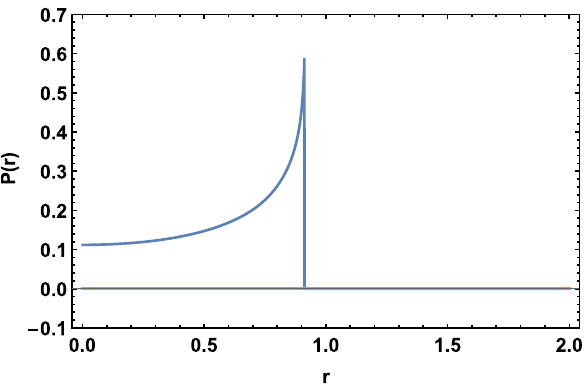
Fig. 8 Radialdependenceofthepressureforthepolytropicgassystem. Forthistypeofmatter,andthechosenparameters,thepressureincreases asthedistancetotheboundarybecomessmaller.Thisisatvariancewith the case of the elastic body, as shown in Fig.